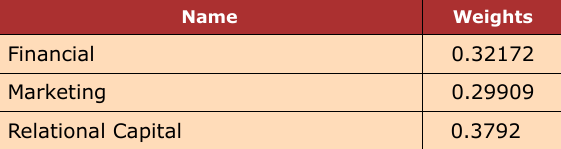
Table 6. Economic Performance Indicators Priorities